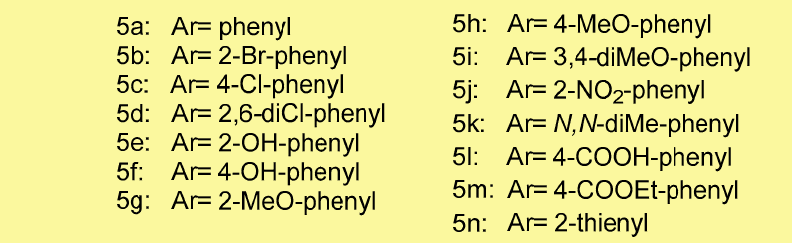
Scheme 1. Synthesis of compounds 5a –